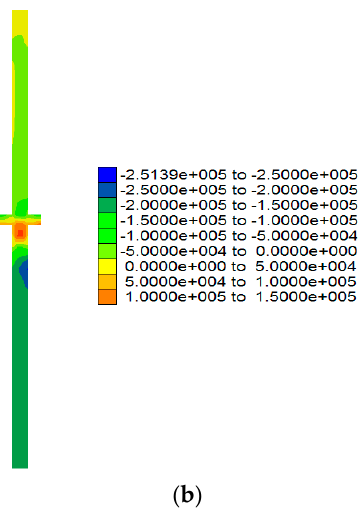
Figure 21. Comparison of minimum principal stress distribution of cut-off wall at monitoring surface. ( a ) 1. ( b ) 2.